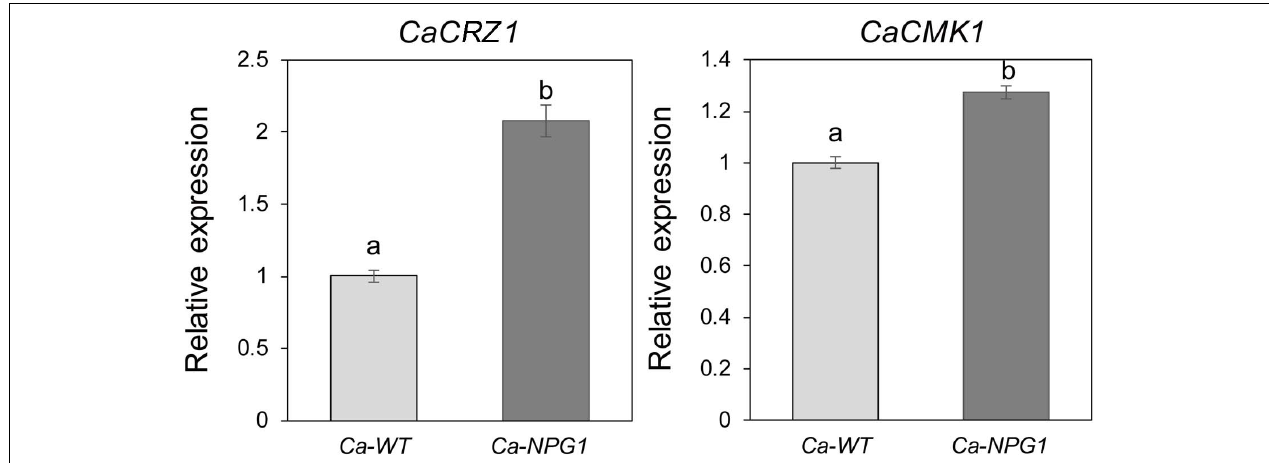
FIGURE 8 | Quantitative RT-PCR analysis. Relative expression levels of CaCRZ1 and CaCMK1 were estimated using the 2 − (cid:49)(cid:49) Ct method with beta-tubulin 1 as the reference gene. Error bars indicated standard deviation, and columns with different letters indicate significant difference ( P <